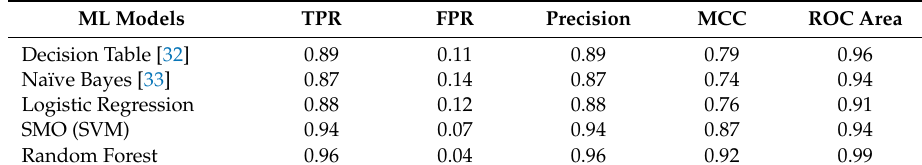
Table 3. Comparisons of machine learning (ML) algorithms using the true positive rate (TPR), false positive rate (FPR), Precision, Matthews correlation coefficient (MCC), and receiver operating characteristic (ROC) area. All algorithms found the same number of false positives as false negatives, so the TPR (also known as Recall) and Precision values were the same. Therefore, the algorithm with the highest number of TPR/Precision and lowest FPR was the best algorithm.